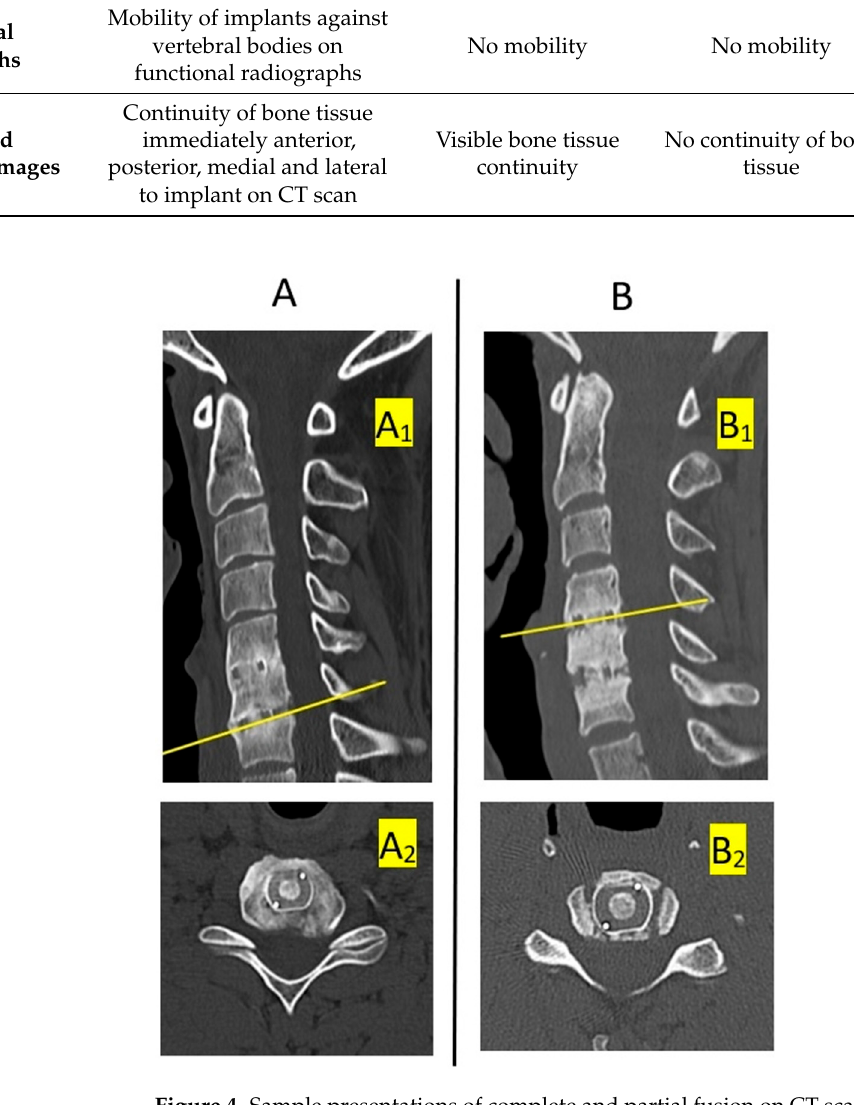
Figure 4. Sample presentations of complete and partial fusion on CT scans at 12 months post-sur-